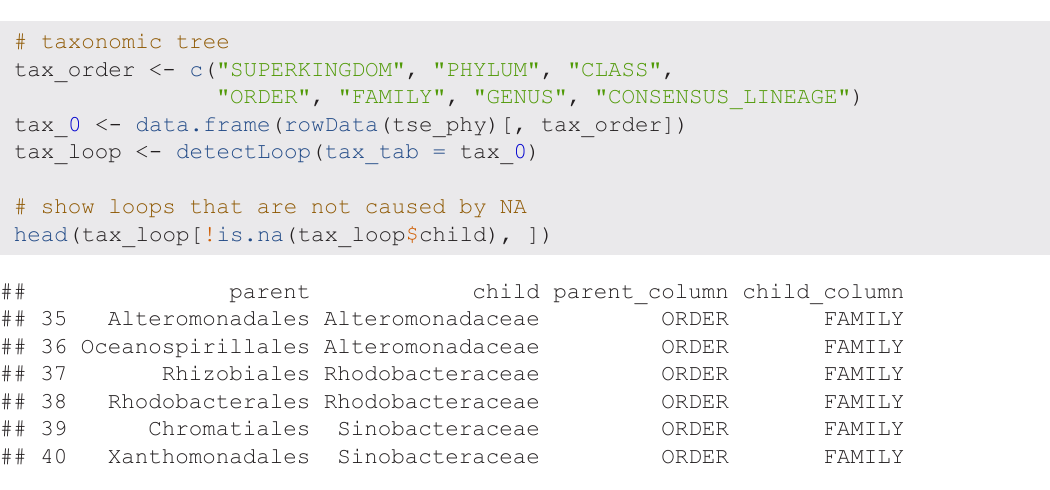
To resolve the loops, we add a suffix to the polyphyletic genus with . For example, resolveLoop Ruminococcus belonging to the and the families become Lachnospiraceae Ruminococcaceae Ruminococcus_1 and , respectively. A tree is created afterwards using Ruminococcus_2 phylo toTree